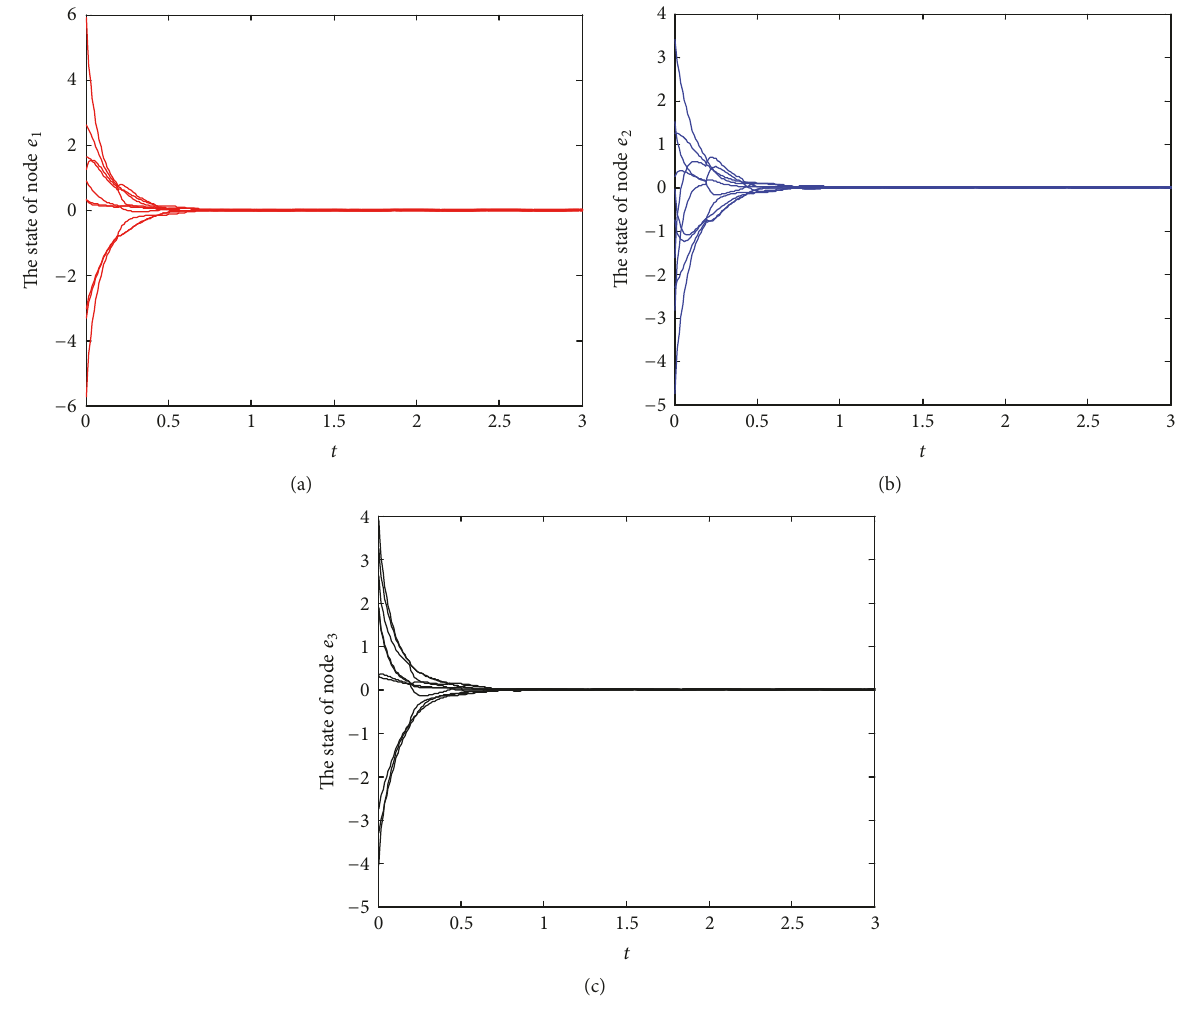
Figure 1: Synchronization error system that satisfies the conditions.